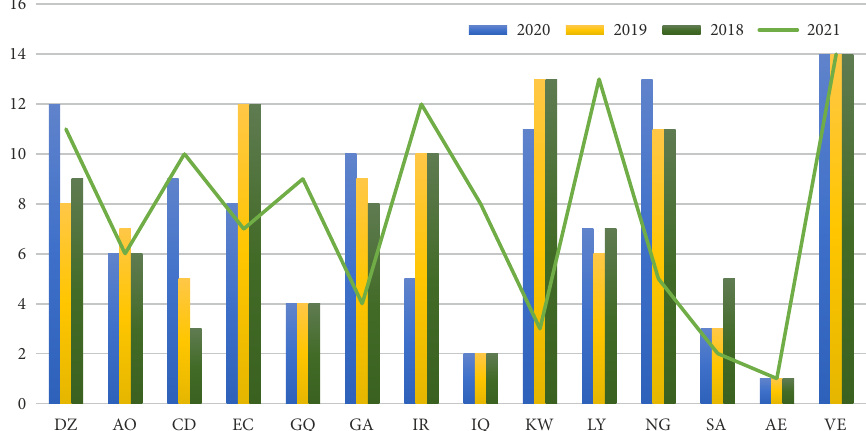
Figure 5. Multi-period assessment of OPEC